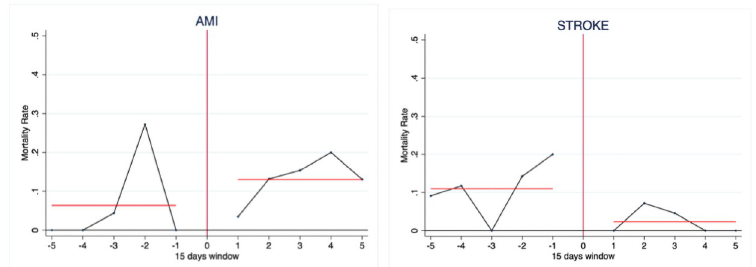
Fig 1. Observed 15-days windows mortality rates around the lockdown cutoff (March, 9 th 2020). The red lines identify the average mortality in the pre and post lockdown periods.